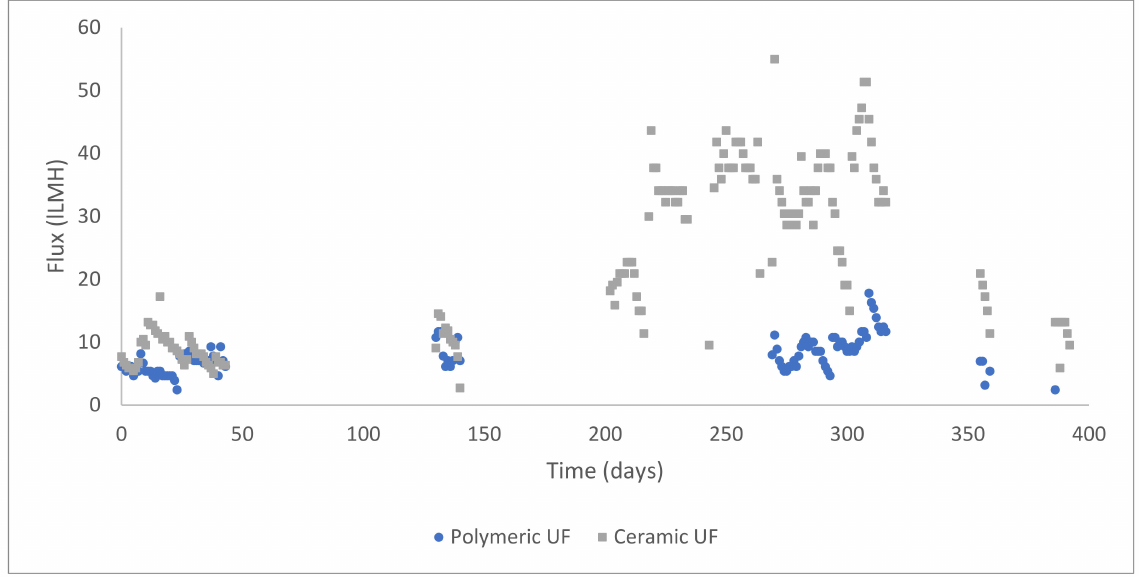
Figure 4. Flux of the Polymeric UF line and the Ceramic UF line. The monitored operational time is 392